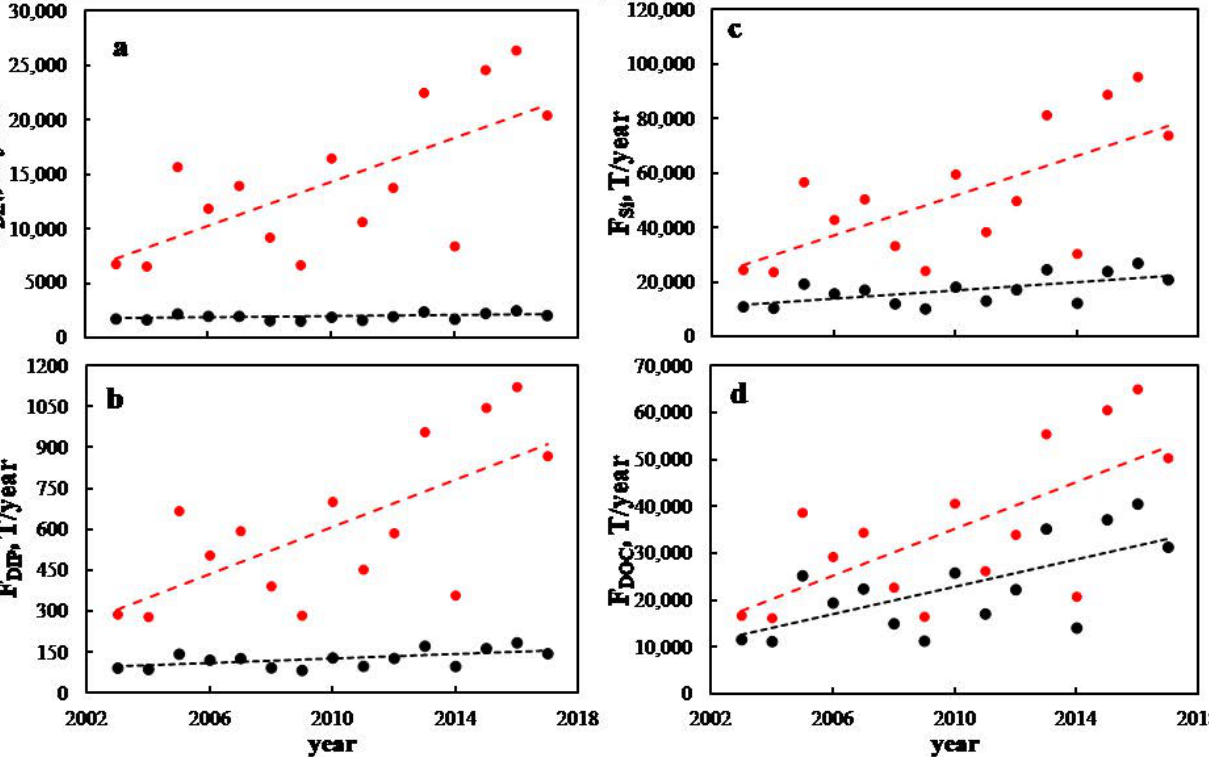
Figure 8. Annual fluxes of ( a ) DIN, ( b ) DIP, ( c ) silica, ( d ) DOC supplied by the Razdolnaya River into Amursky Bay (black circles) and by the Tumannaya River into the JES (red circles) in